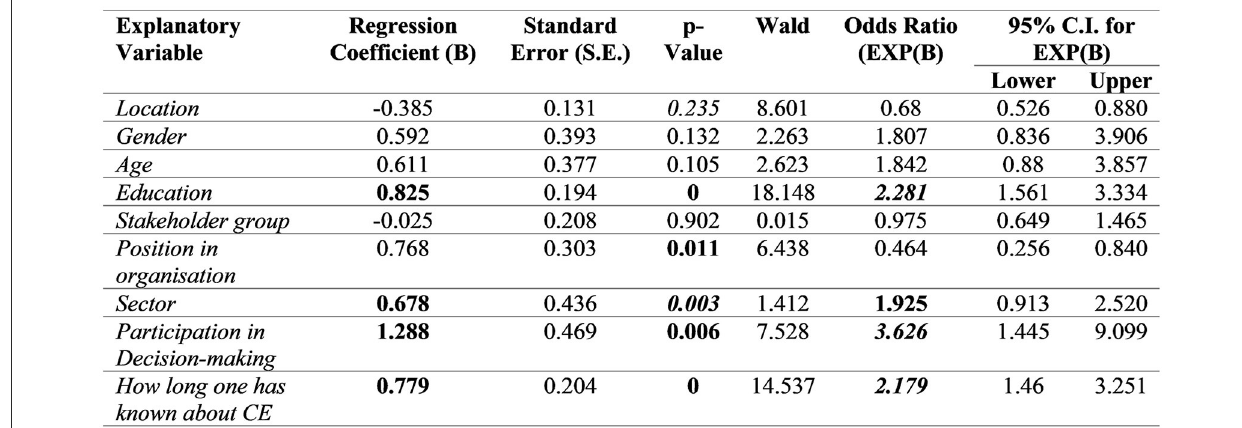
FIGURE7 Determinants of respondents CE knowledge.